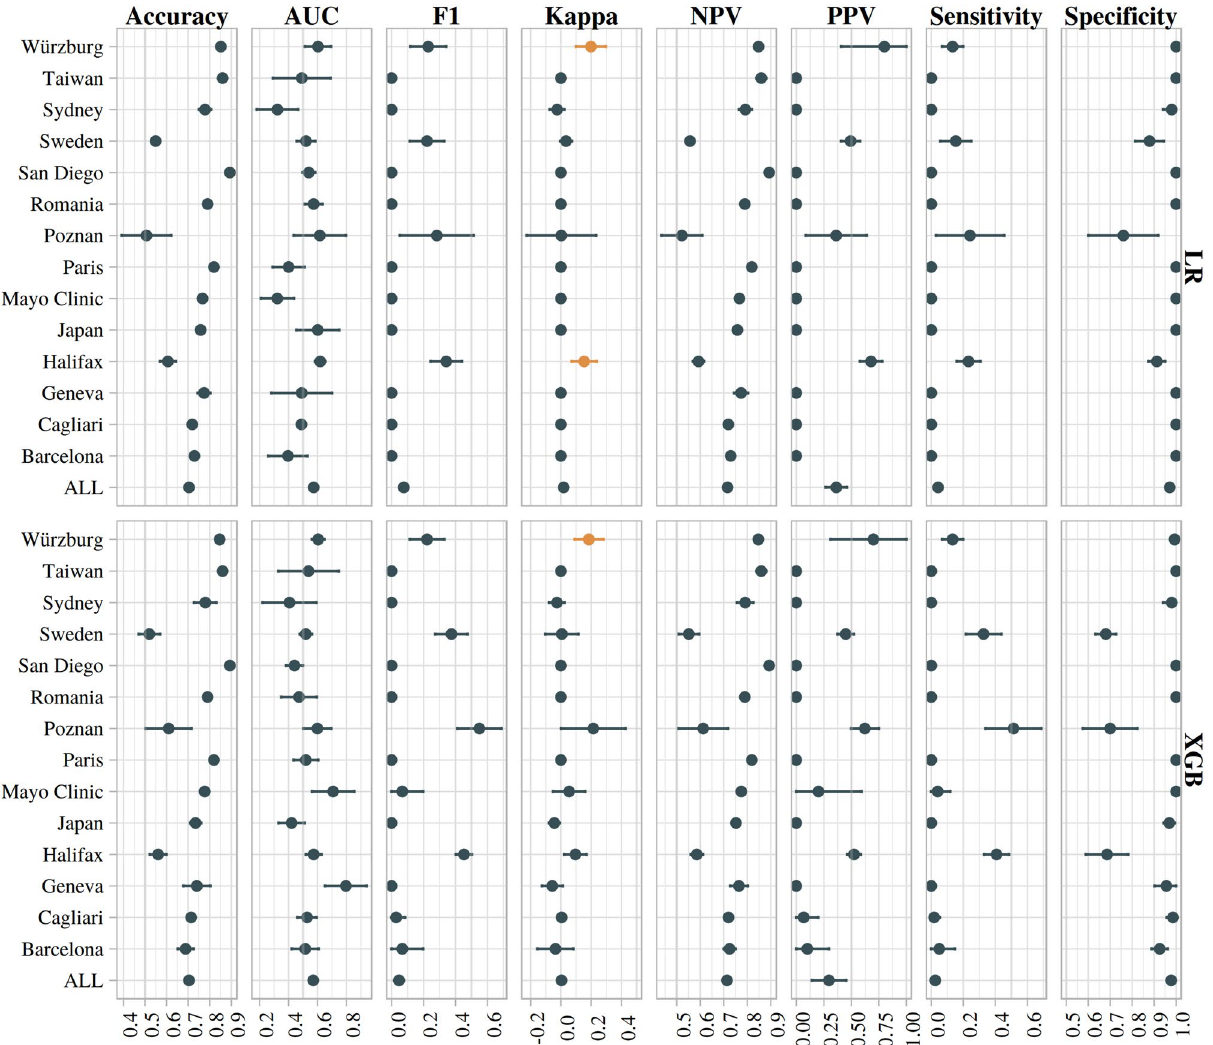
Figure 1. Performance of the logistic regression (LR), and XGBoost (XGB) classifiers on the aggregate and site- level analyses. Faceting of plots along columns corresponds to different classification statistics. Faceting along rows corresponds to the aforementioned classification algorithms. Within each plot, the x-axis represents the statistic value, and the y-axis corresponds to the dataset under which the classification analysis was performed. Plot markers denote the mean performance over the respective number of cross-validation folds, with error bars denoting the empirical 95% confidence intervals. In the column for Kappa, where the p value from the criticism analysis fell below 0.01 in comparison to the null classifier we coloured the point yellow to represent exceedance of chance; all other points are coloured dark blue. Abbreviations: all sites (ALL; i.e. aggregate analysis), area under the receiver operating characteristic curve (AUC), positive predictive value (PPV), negative predictive value (NPV), F-1 score